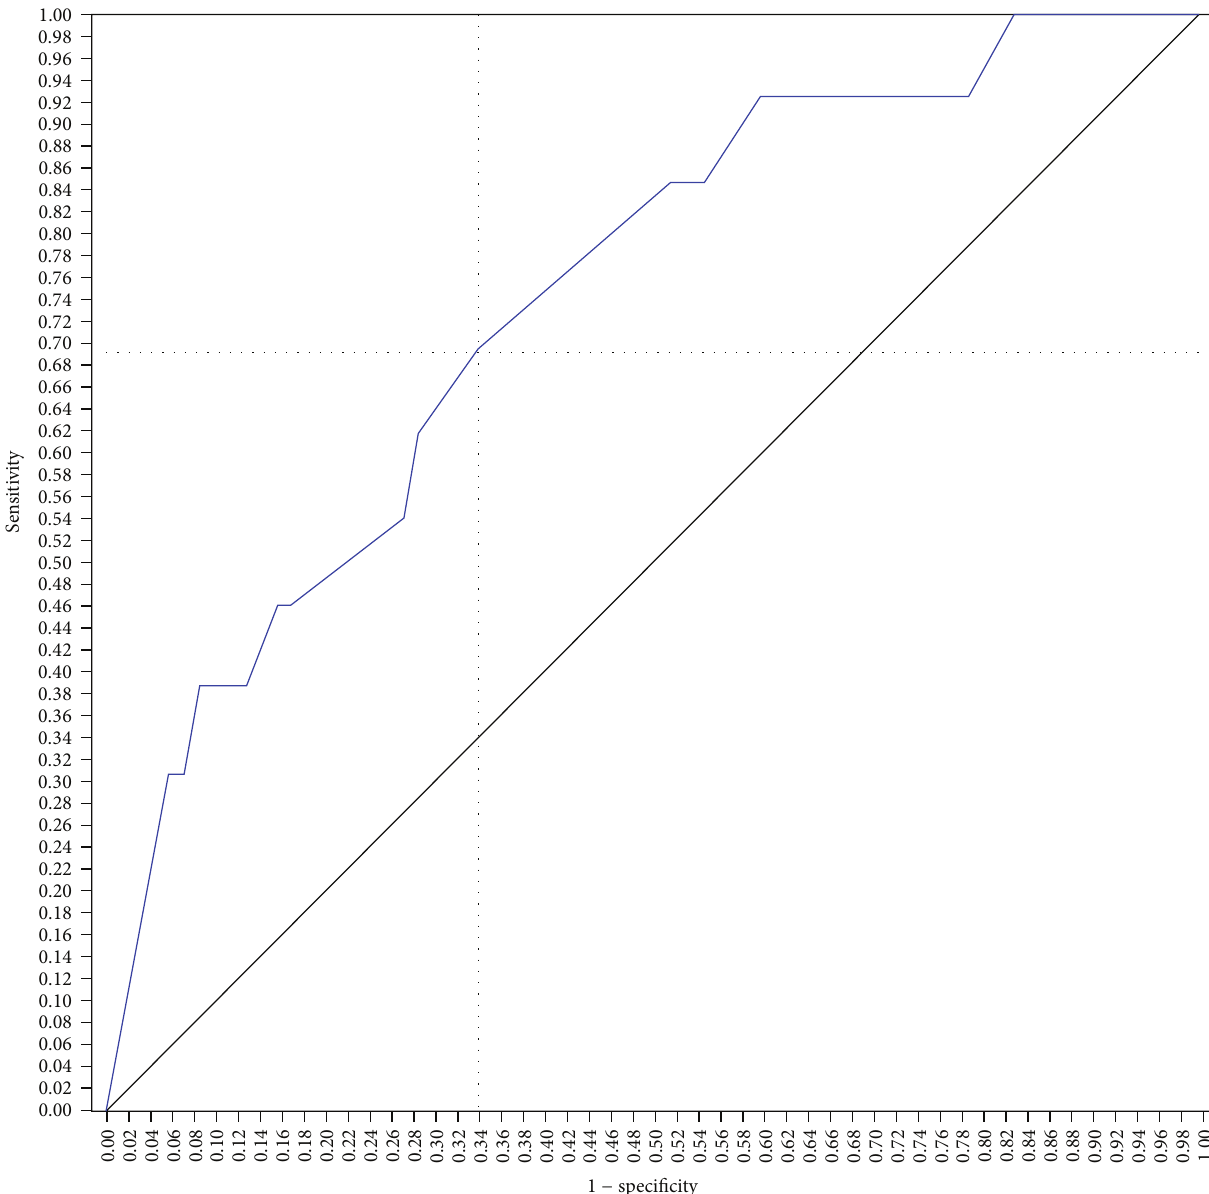
Figure 3: APACHE 2 ROC curve for prediction of hospital mortality. The score of 13 showed better sensitivity (69%) and specificity (66%) for hospital mortality, with an area under the curve of 0.74 (area = 0.5; 𝑃 < 0.006 , 95% CI;